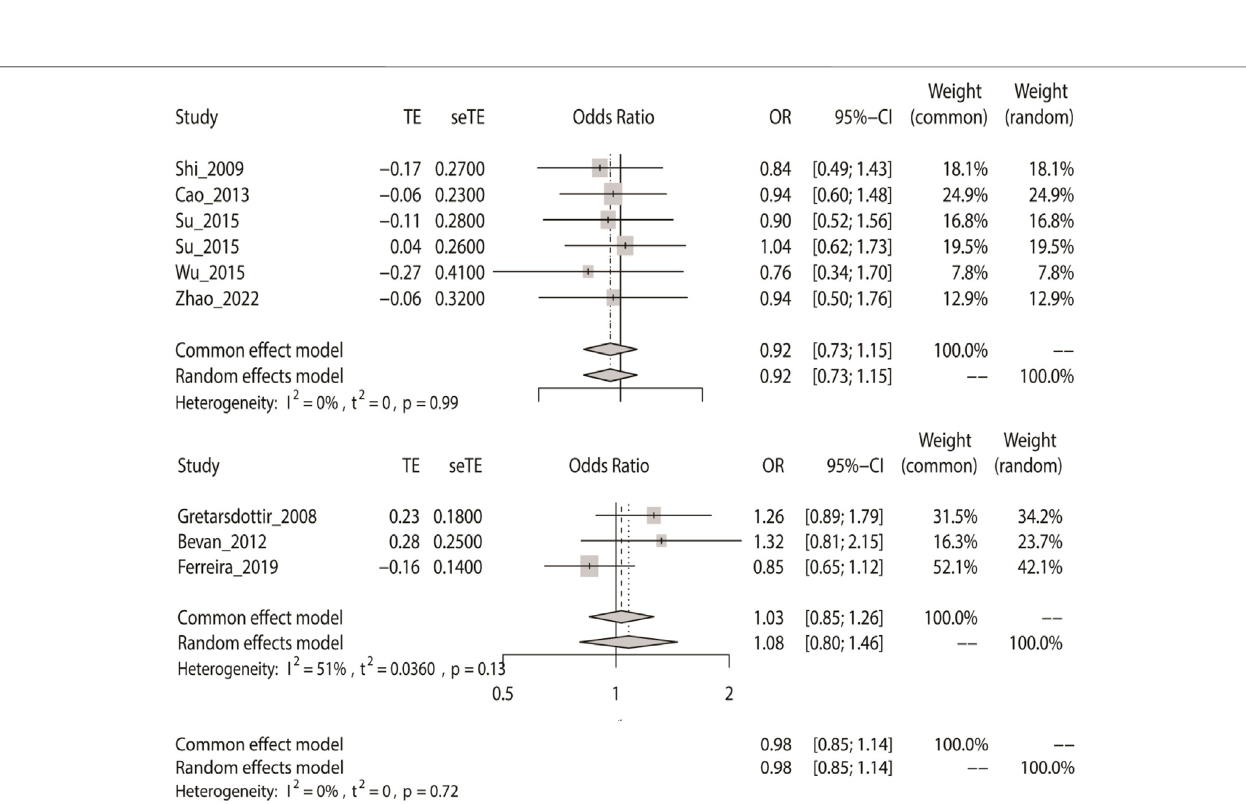
Frontiers in Genetics |